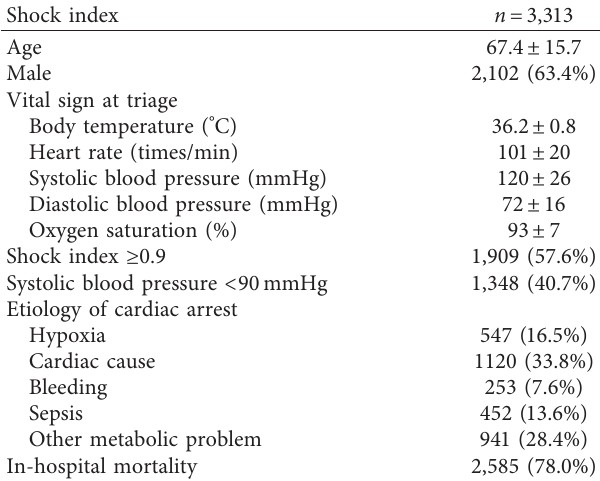
Table 1: Demographics of patients who developed cardiac arrest in the emergency